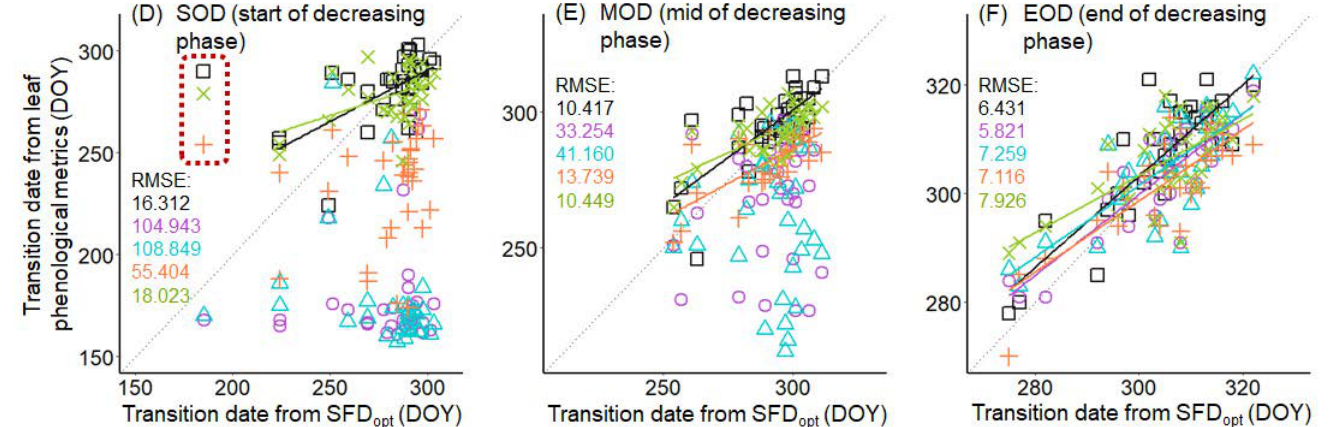
Figure 6. Comparison of phenological transition dates between optimized sap flux density (SFD opt ) and leaf phenological metrics. Each point represents data for an individual tree. Dotted lines are 1:1 lines and solid lines are the significant linear regression equations ( p < 0.05). For panel ( D ), three outlier points surrounded by the thick dotted line were excluded from the analysis (when the outlier points were included in the regression analysis, the significant correlations in crown leaf cover based on ground observation CLC ground and Hue were still maintained). Abbreviations: GCC, green chromatic coordinate; GEI, green excess index; GRVI, green-red vegetation